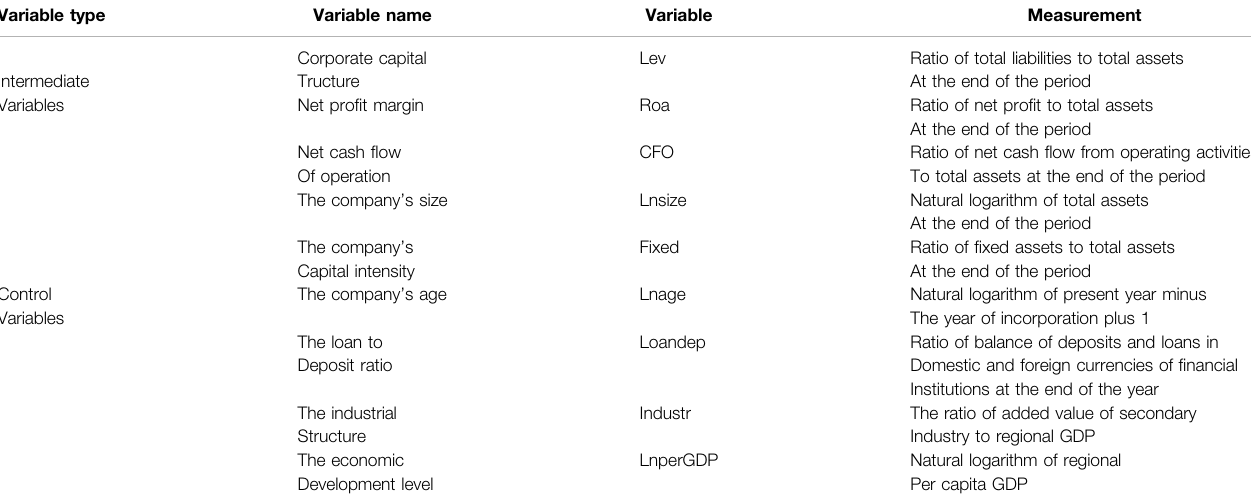
TABLE 1 | Intermediate variables and control variables.